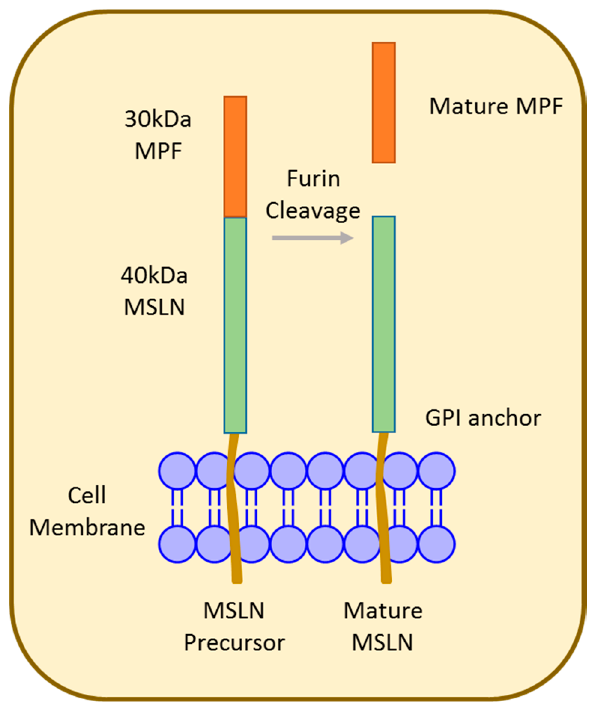
Figure 2. Structure of mesothelin (MSLN). The 70 kDa MSLN precursor protein is proteolytically cleaved to release the 30 kDa N-terminal megakaryocyte potentiating factor (MPF) and is displayed as mature MSLN on the cell surface.